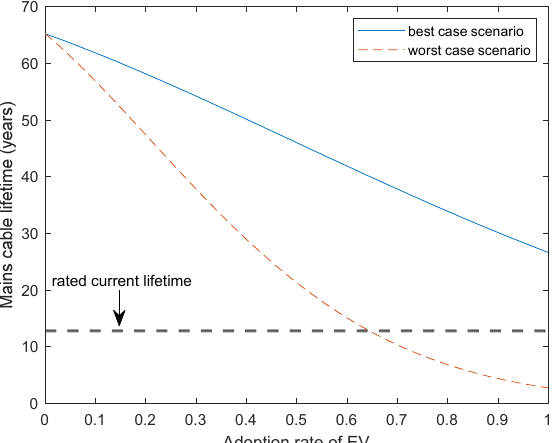
Figure 8. The lifetime of the mains’ cable with EV adoption rate.